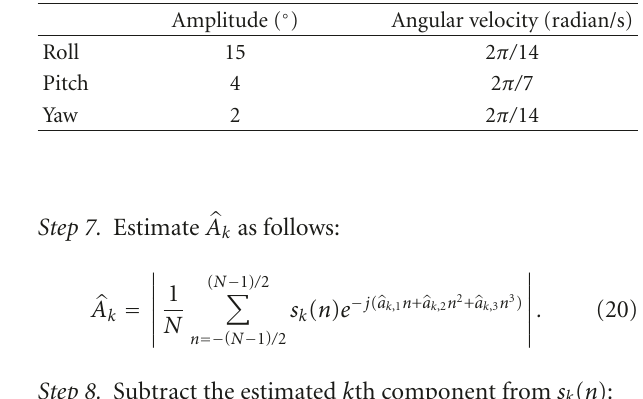
Figure 4: Coordinate systems of Radar and ship target.